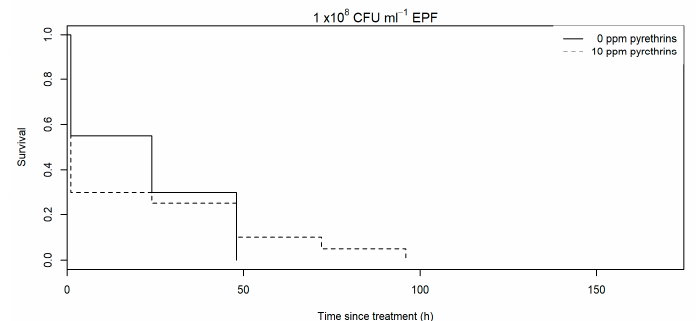
Figure 1. Survival of individual A. fabae exposed to M. anisopliae alone (solid line) or in combination with pyrethrum (dotted line). Entomopathogenic fungus (EPF) was tested at 0 colony forming units (CFU) mL − 1 (carrier oil only, top graph), 1 × 10 6 CFU mL − 1 (middle graph) and 1 × 10 8 CFU mL − 1 .